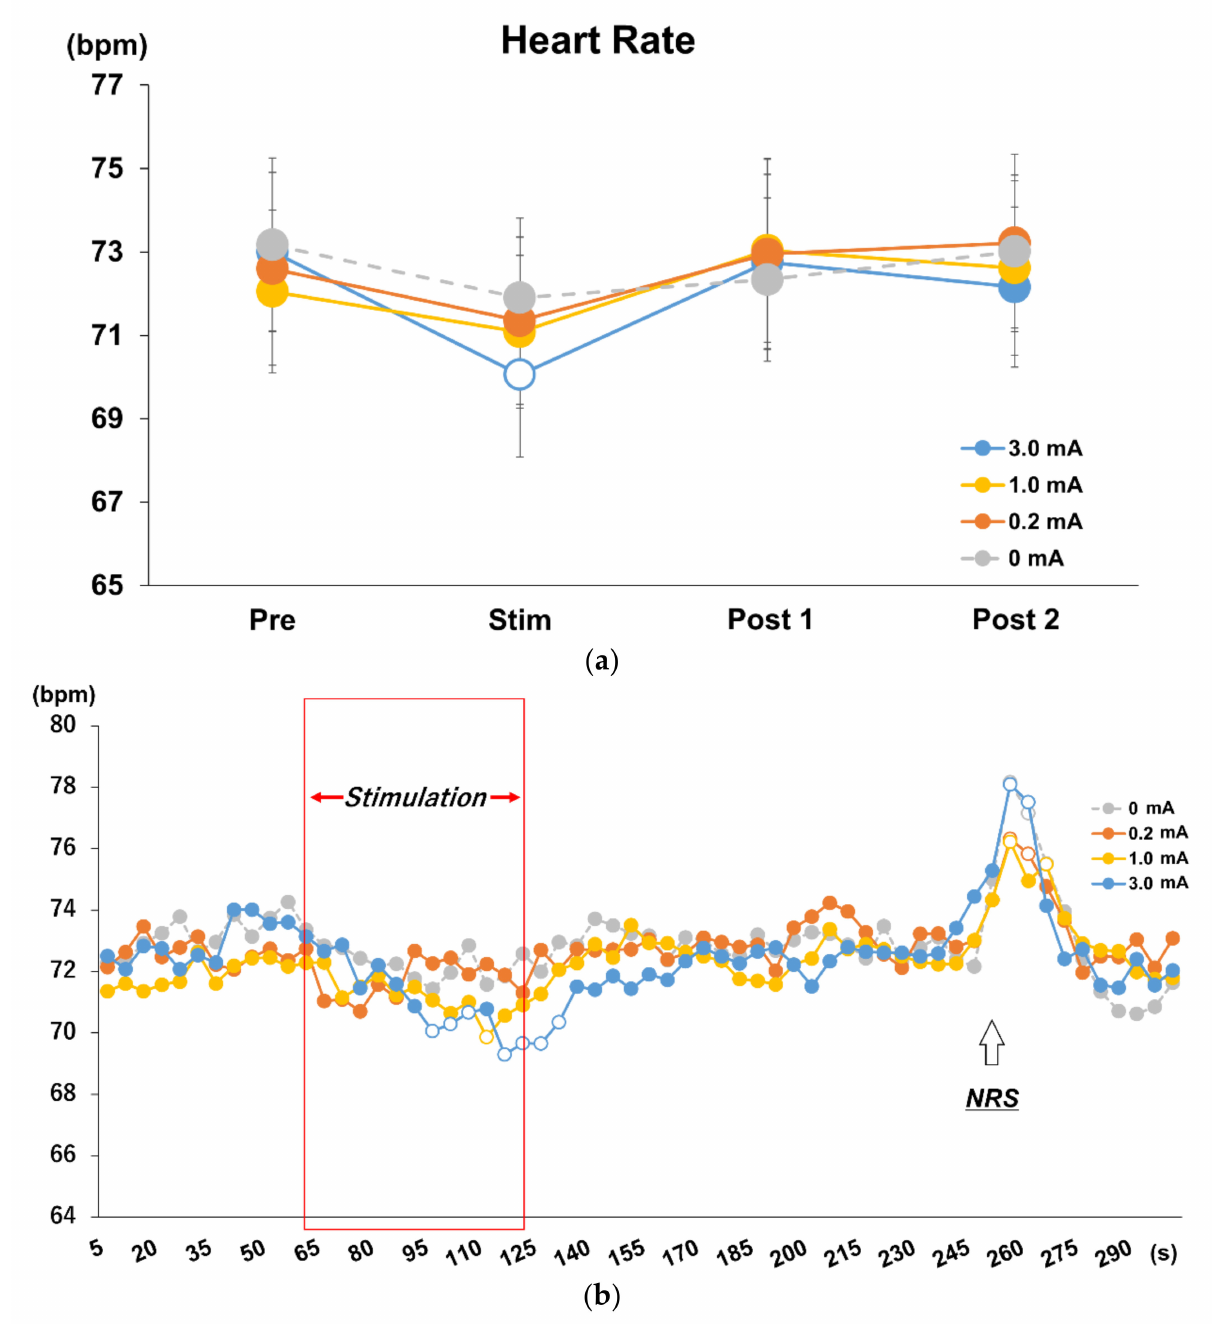
Figure 4. ( a ) Effects of different stimulus intensities of tVNS on HR. Repeated measures two-way ANOVA revealed main effects and interactions for intensity and time factors (F = 1.951, p = 0.049). Post hoc analysis revealed a decrease in HR during stimulation only in the 3.0 mA condition compared to baseline ( p = 0.005), Post 1 ( p = 0.003), and Post 2 ( p = 0.023). ( b ) Time course analysis on every 5 s in each stimulus intensity condition. Post hoc analysis using Dunnett’s method revealed different effects during stimulation for each stimulus current intensity, and rebound was observed during NRS administration 10 s after the end of Post 2 (shown as an upward-pointing arrow) rather than at the end of stimulation ( p < 0.05). White dots indicate significant